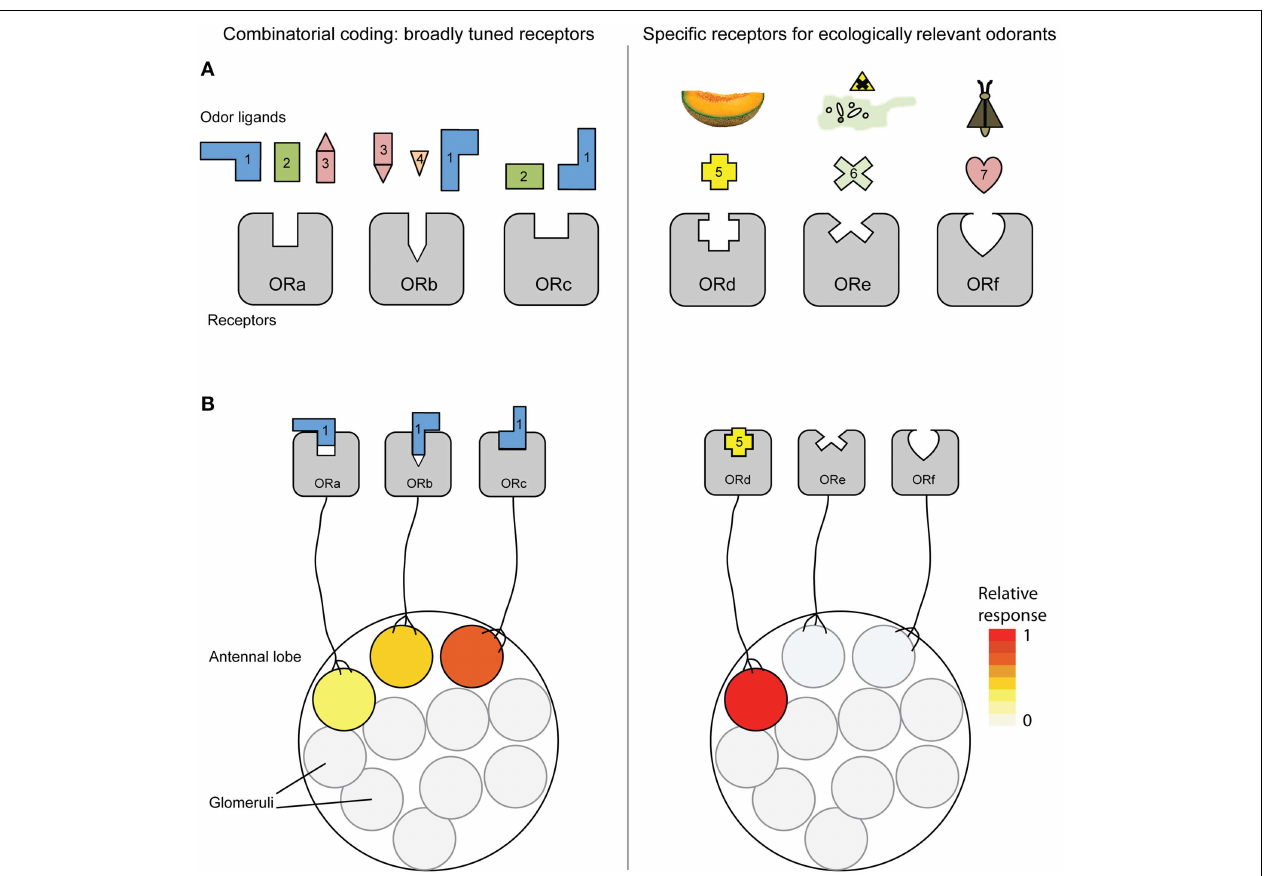
few structurally related odorants, and little cross-activation of ORs occurs (right). (B) With combinatorial coding, a single odorant activates a unique combination of glomeruli in the antennal lobe (left) due to binding to multiple ORs, whereas a single odorant activates a single glomerulus in a system comprised of specialized ORs and dedicated channels